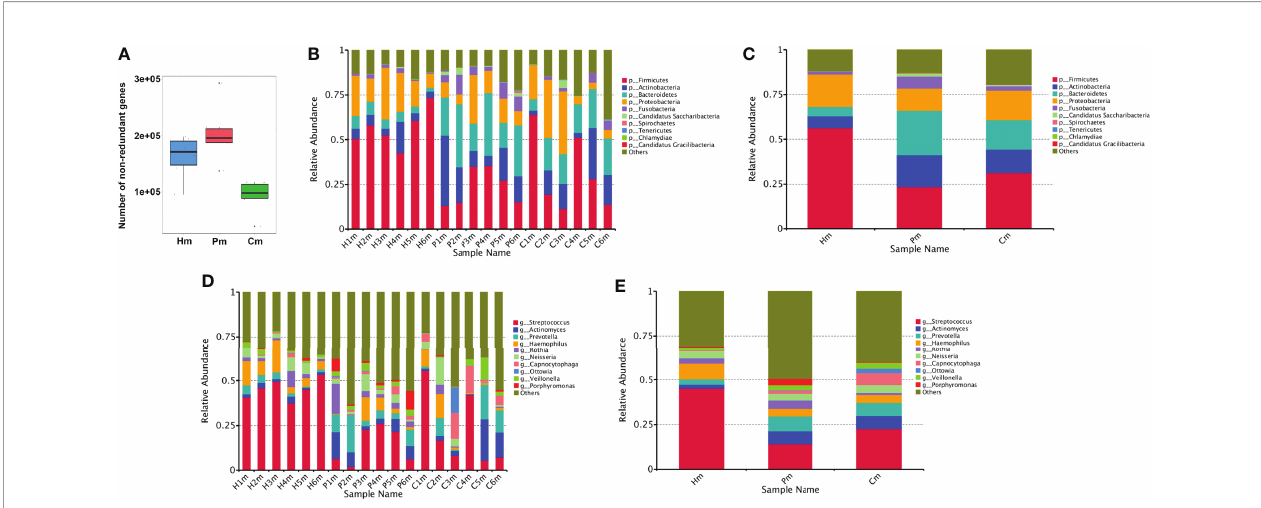
FIGURE 1 | Number of non-redundant genes and taxonomic distribution in the oral microbiome of individuals in the Hm, Cm, and Pm groups. (A) Box plot indicating the number of non-redundant genes. Barplots of the relative abundances of different taxa at the phylum level among (B) all the samples and (C) different groups. Barplots of the relative abundances of different taxa at the genus level among (D) all the samples and (E) different groups. Hm, healthy individuals; Pm, patients with periodontitis alone; Cm, patients with Crohn ’ s disease and periodontitis.